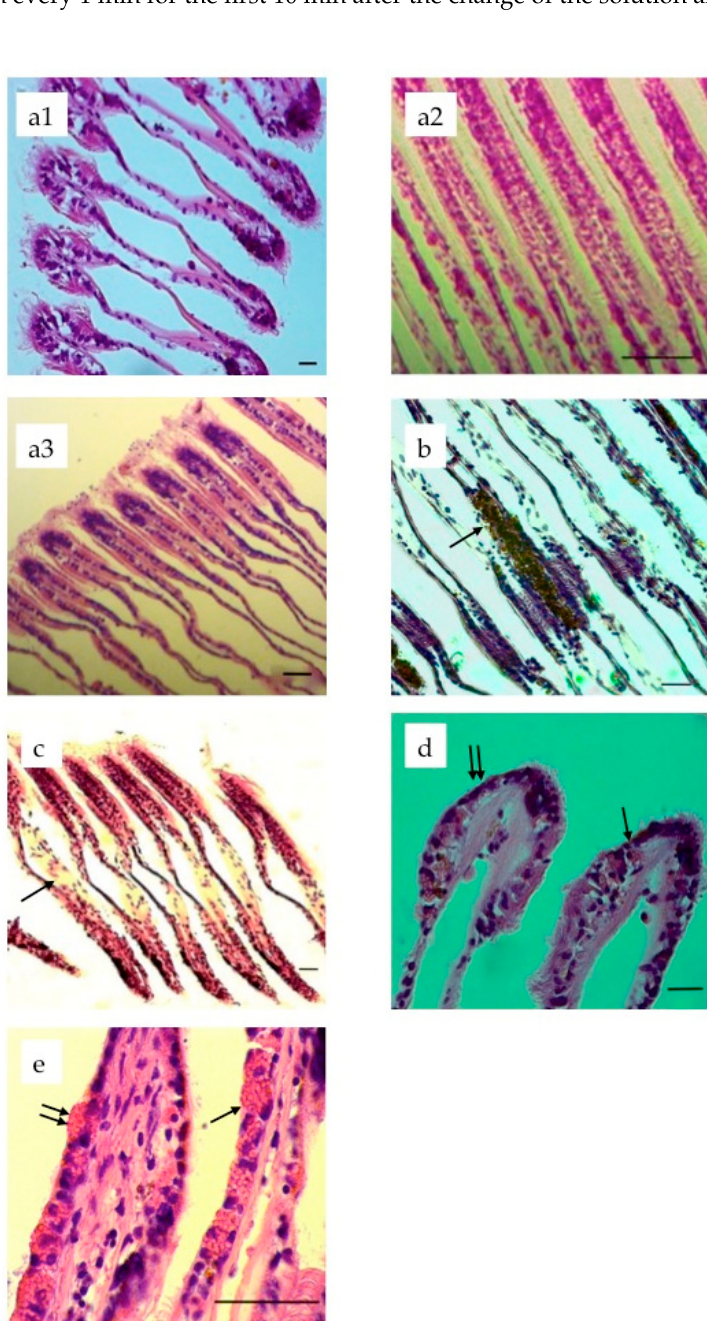
Figure 1. Representative histological sections of Mytilus galloprovincialis gills (H & E staining), normal gills of a control mussel 40× ( a1 ), 20× ( a2 ) and 10× ( a3 ); animals exposed to 1.0 mg/L of quaternium-15, after the 18-day exposure, melanin deposit (arrow) and lack of cilia (single arrow), 20× ( b ); animals exposed to 1.0 mg/L of quaternium-15 after the 18-day exposure, gill filaments filled with haemocytes (arrow), 10× ( c ); animals exposed to 2.0 mg/L of quaternium-15, after the 18-day exposure, haemocytes inside the epithelium (arrow), and lack of cilia (double arrows), 63× ( d ); animals exposed to 2.0 mg/L of quaternium-15, after the 18-day exposure, goblet cells increased in volume with granules inside cytoplasm (single arrow). Double arrows indicate these granules probably during releasing process, 100× ( e ). Each scale bar = 50 μ m.